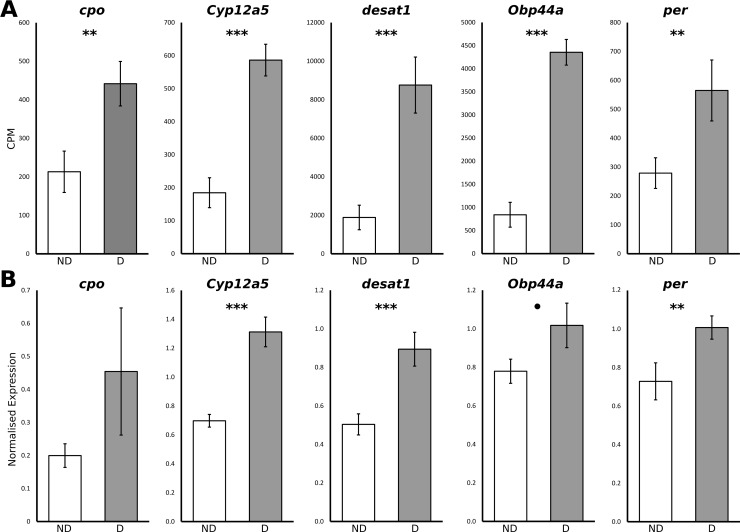
Estimating the effect of the tissue heterogenity.Normalized gene expressions levels comparing diapausing and non-diapausing D. montana females A) from the RNAseq analysis (for comparison), and B) from the qPCR using the females whose ovaries had been removed before RNA extractions. Both data sets present the combined data for all the three isofemales strains (see text for details). CPM = counts per million. Significance levels for qPCR: •0.1 > P > 0.05, **0.01 > P > 0.001, ***P < 0.001.